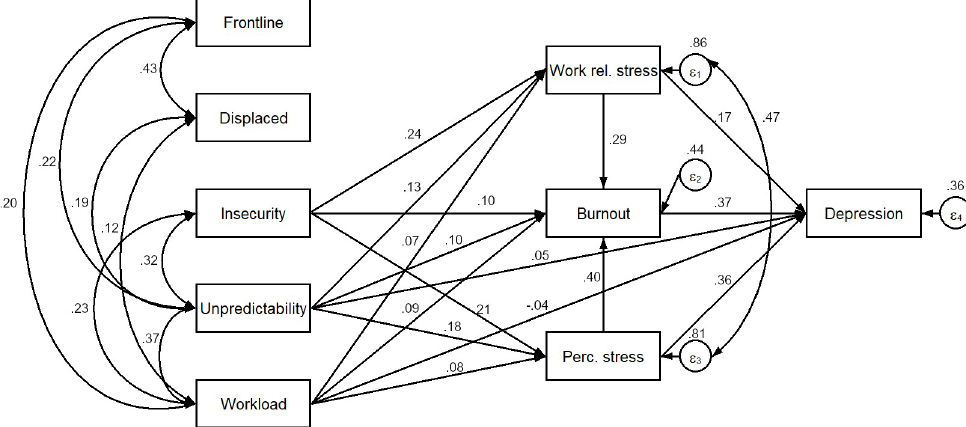
Fig 2. Relationship between COVID-19 related factors and mental health (final SEM model). Note. Control variables (age, sex) and non-significant correlations are not presented. Figure shows standardized coefficients, correlations and variances of error terms. ε 1–4 error terms of the four